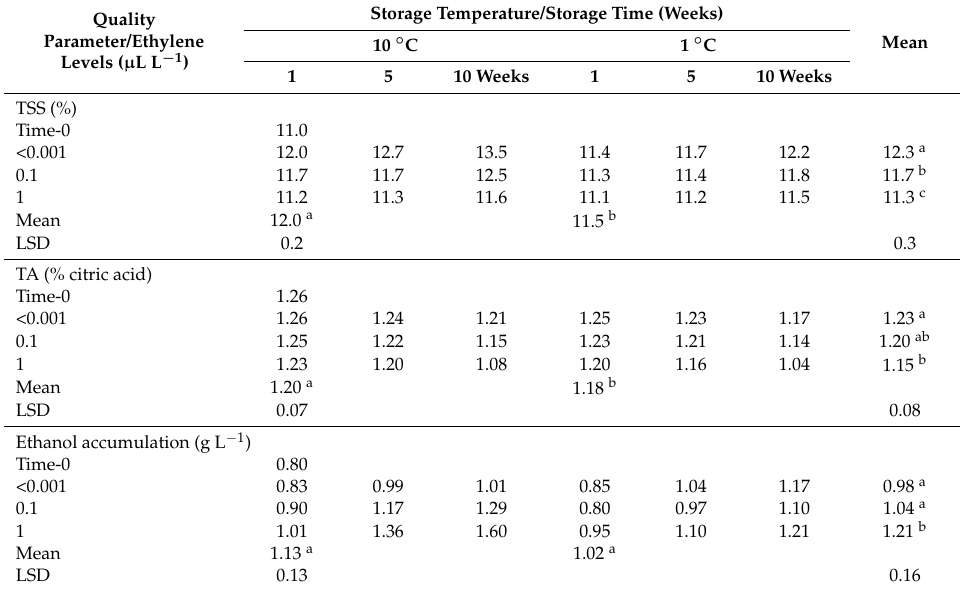
Table 5. TSS, TA and ethanol accumulation of Navel oranges stored at 1 and 10 ◦ C. Quality